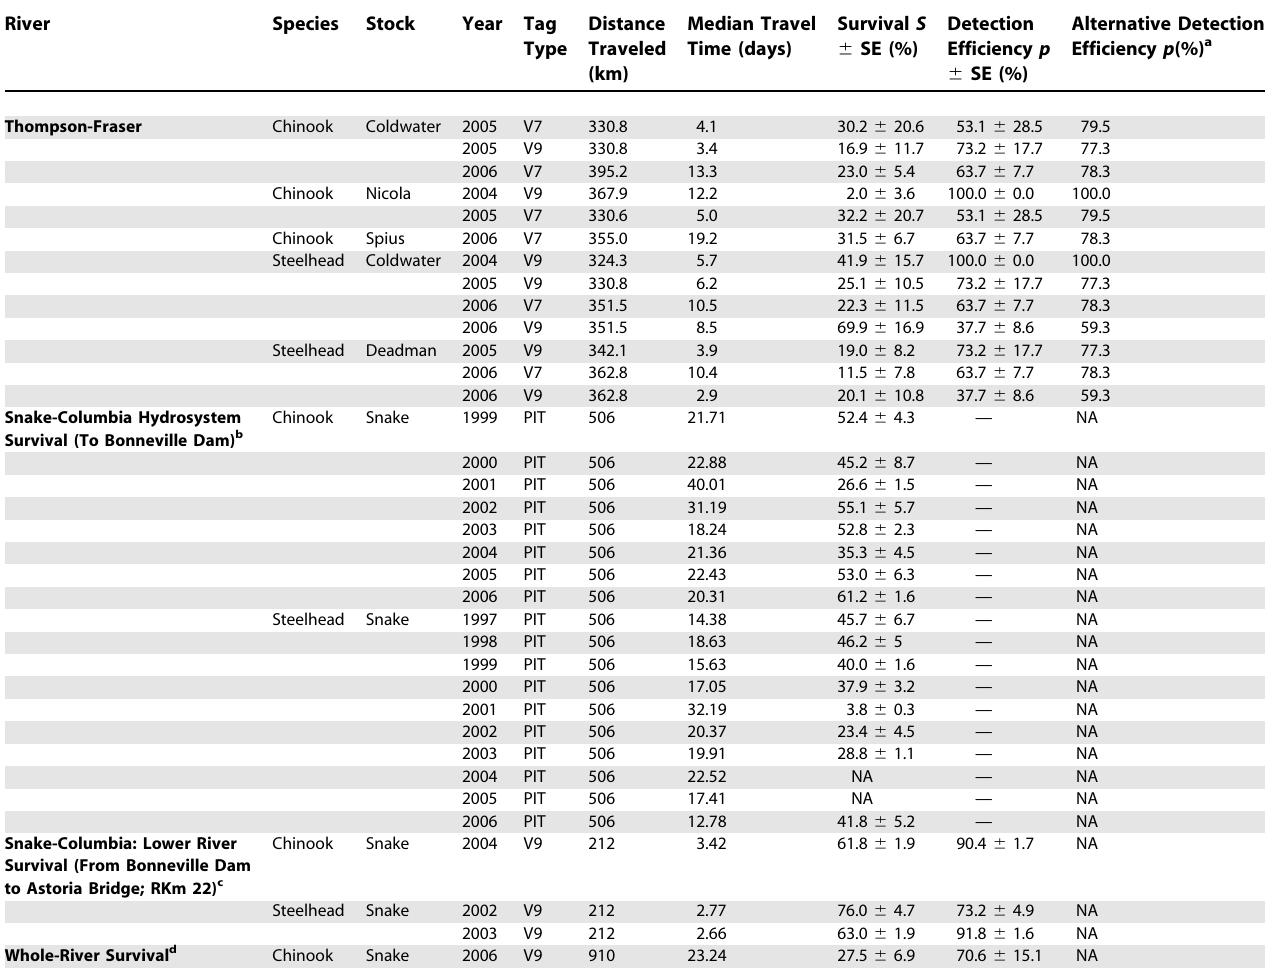
Table 1. Estimated Survival of Snake and Thompson River Smolts River Species